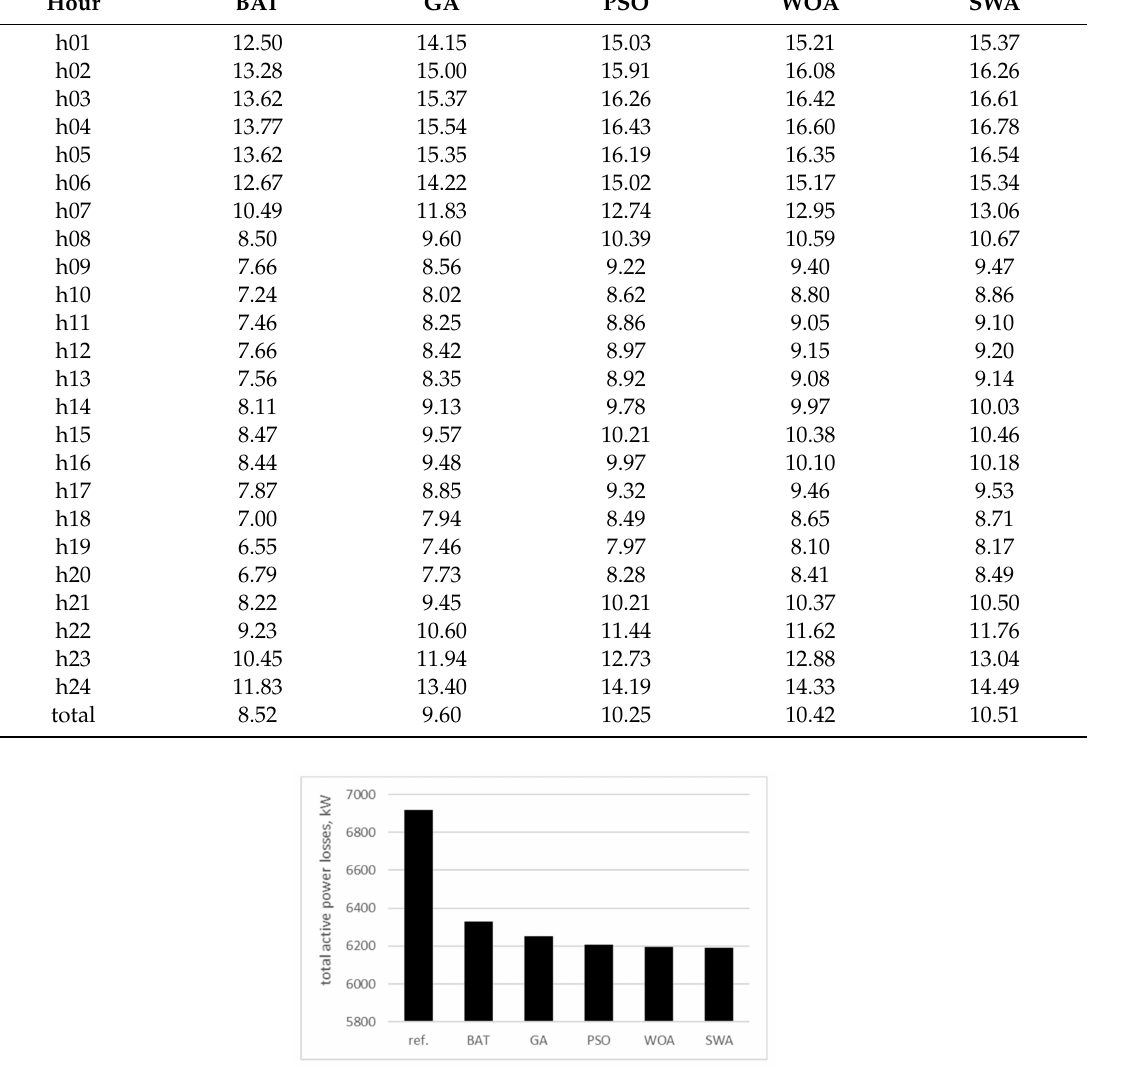
Figure 17. The total active power loss reduction in the IEEE 33-bus system, in kW, for each